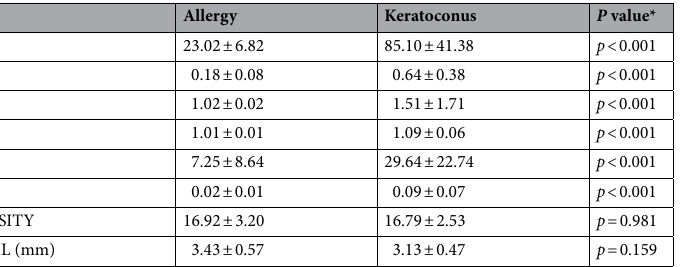
Table 2. Comparison of corneal parameters of pediatric ocular allergy patients to those of pediatric keratoconus patients. Data expressed as mean ± standard deviation. ISV index of surface variation, IVA index of vertical asymmetry, KI keratoconus index, CKI central keratoconus index, IHA index of height asymmetry, IHD index of height decentration, Density optical corneal density, Pupil pupil size in mesopic conditions. *Wilcoxon rank-sum